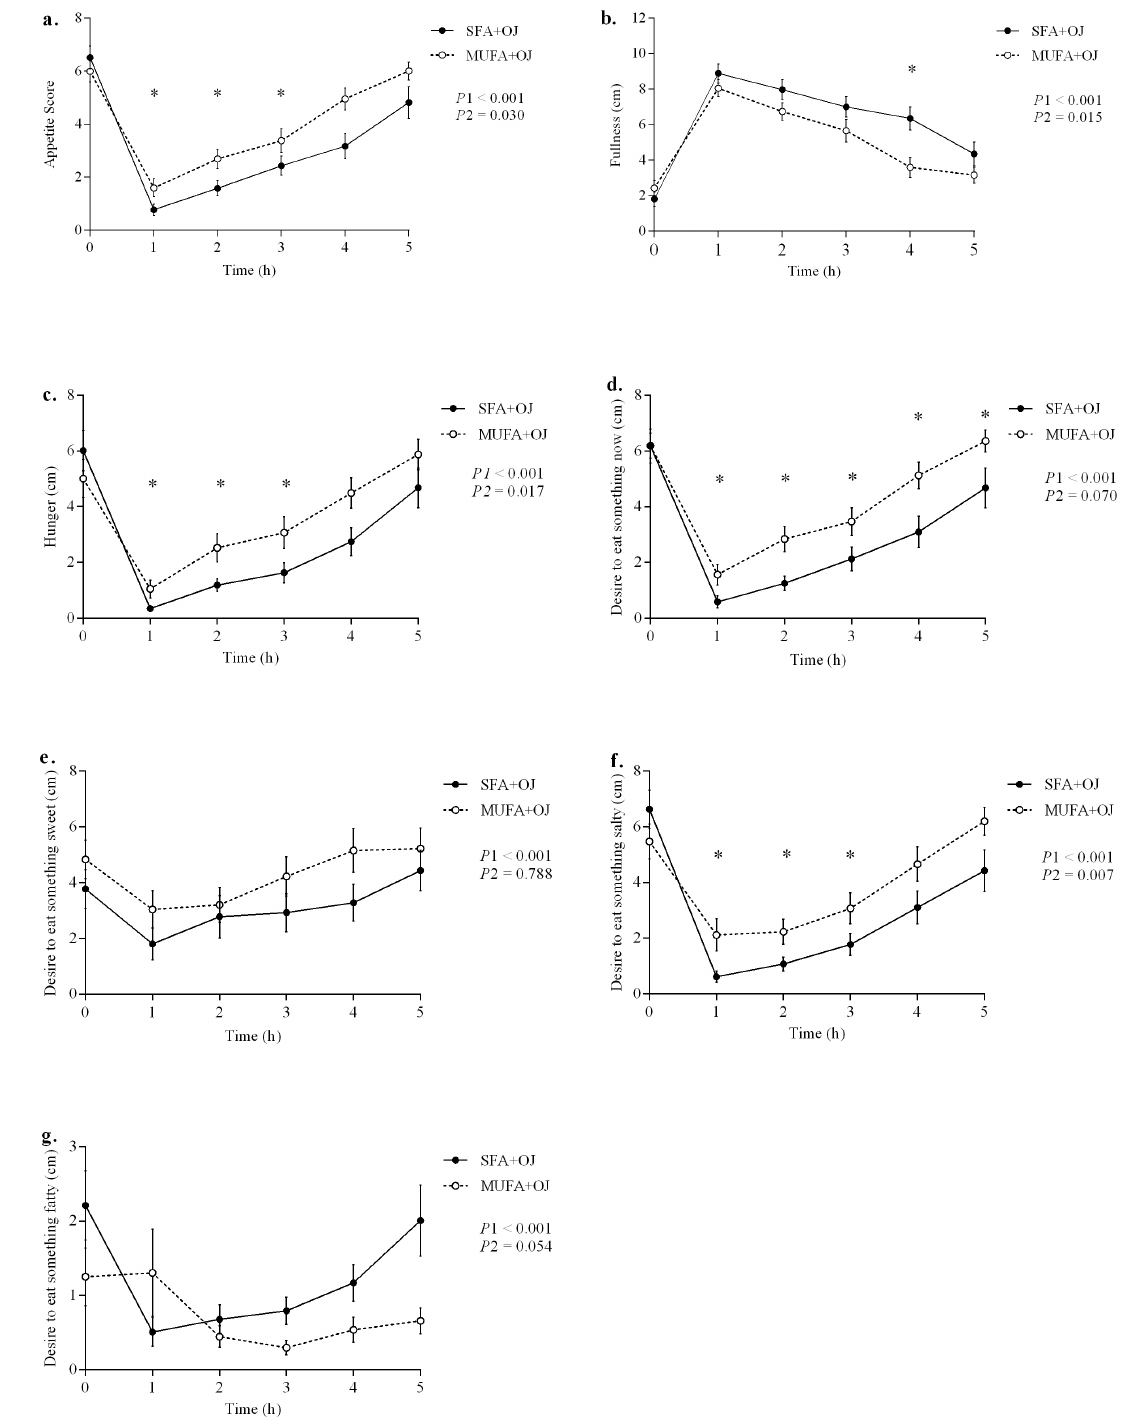
Figure 2. Effect of high-SFA and high-MUFA meals followed by orange juice on a) Appetite Score, b) Fullness (cm), c) Hunger (cm), d) Desire to eat something now (cm), e) Desire to eat something sweet (cm), f) Desire to eat something salty (cm), and g) Desire to eat something fatty (cm) from baseline up to 5 post-prandial hours. SFA: saturated fatty acid; MUFA: monounsaturated fatty acid; OJ: orange juice. Data are presented as mean value ± SEM. P1 = p -value of the effect of time based on two-way mixed ANOVA; P2 = p -value of the interaction of time vs. diet based on two-way mixed ANOVA; * p -values ( p < 0.05) from Student t